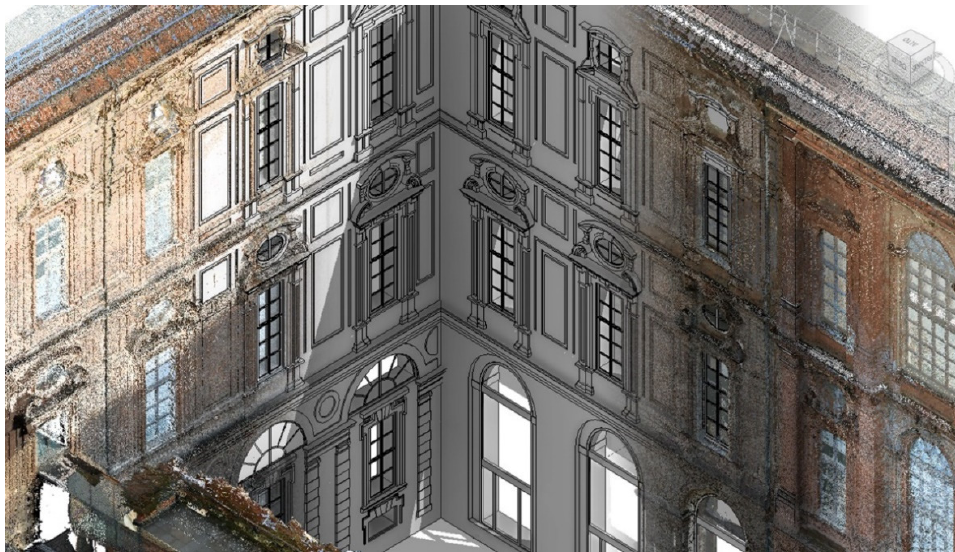
Figure 1. From the point cloud to HBIM model. Virtual model of the Fondazione Museo delle Antichità Egizie di Torino.